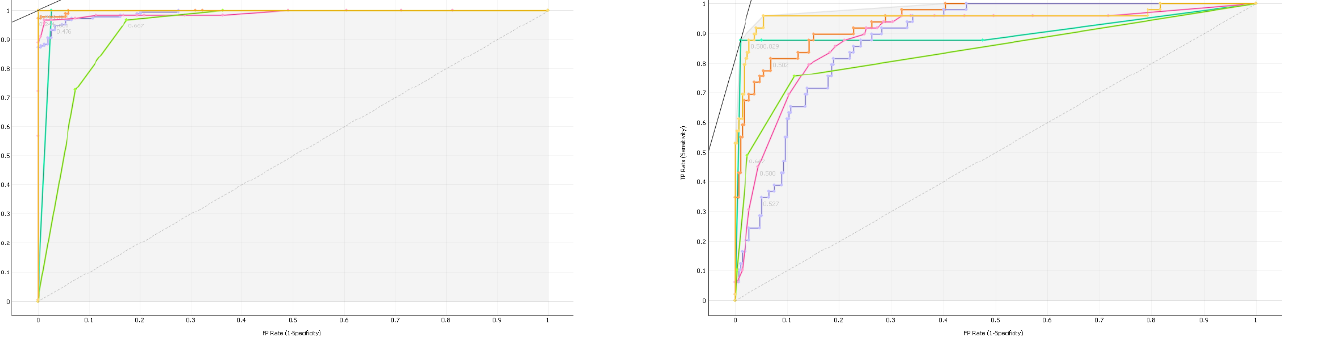
Fig. D2. ROC curve analysis relating to class